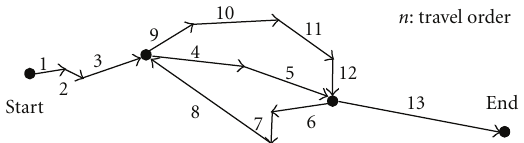
Figure 6: The corresponding linear route after applying the algorithm LINEAR APPROX to the route in Figure